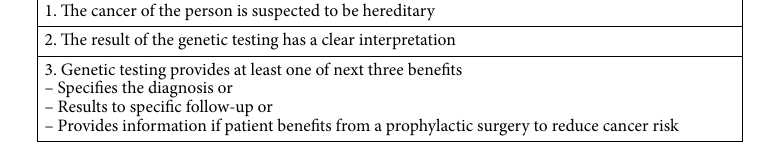
Table 2. Current genetic testing criteria according to American Society of Clinical Oncology 25